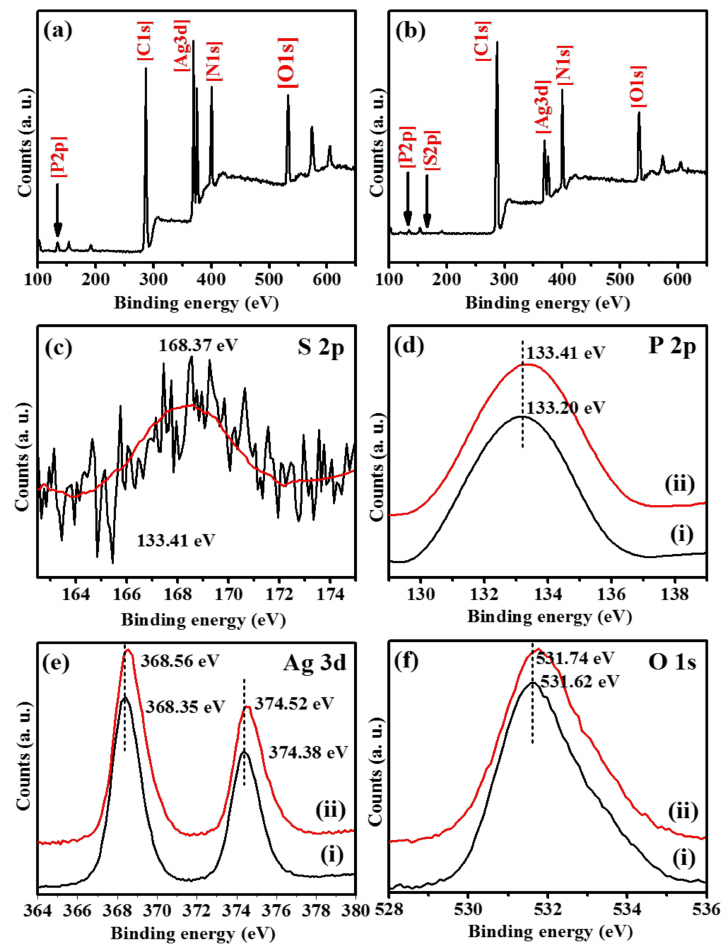
Figure 6. XPS spectra; survey spectra of AP / PAN ( a ) and S-AP / PAN ( b ). Panels ( c – f ) represent the high-resolution spectra of AP / PAN (i) and S-AP / PAN